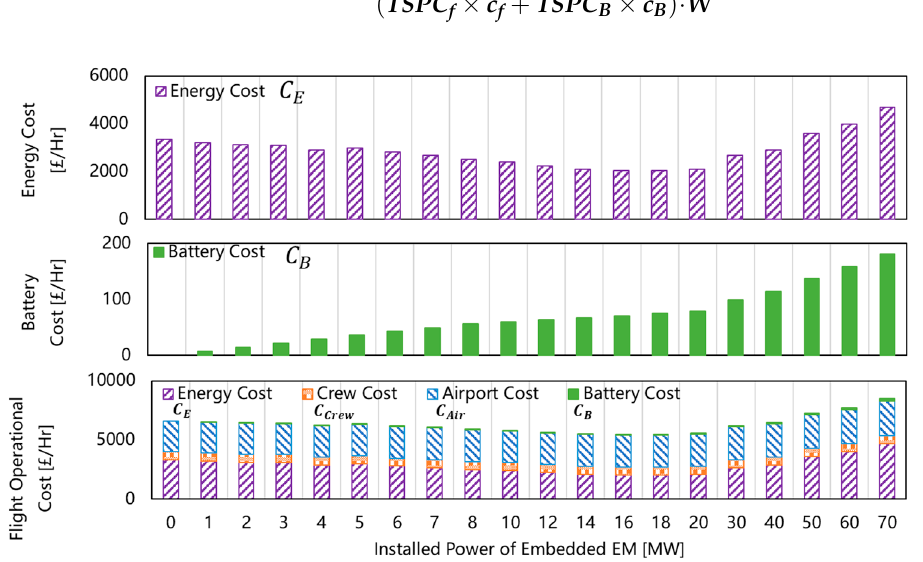
Figure 14. Variation in FOC with different levels of EM power.